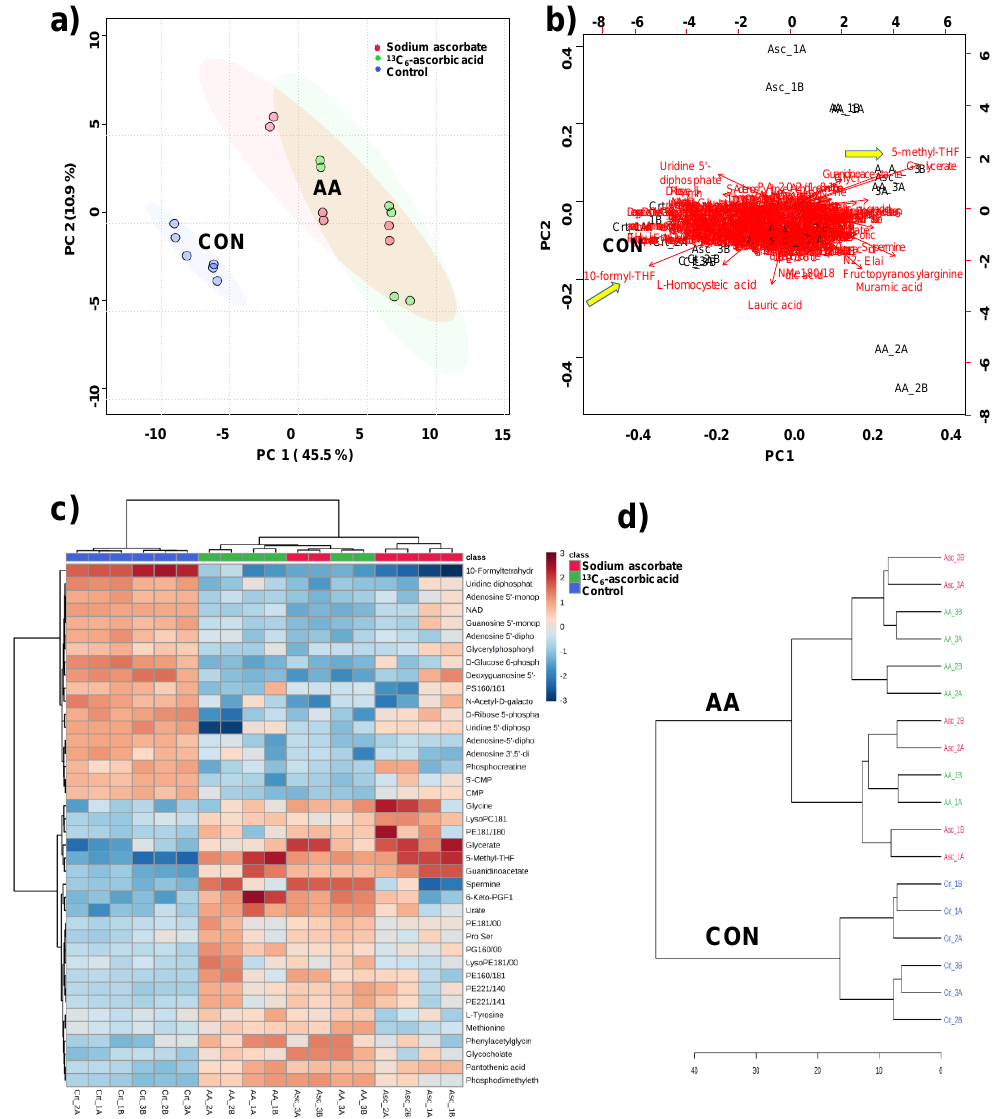
Figure 1. Analysis of treated C2C12 cells with ascorbic acid and with ascorbate 100 µM. ( a ) Principal component analysis (PCA) scores plot, where each dot represents a sample analysis (thus, 6 dots per experiment resulting from biological triplicates and technical duplicates); ( b ) PCA biplot visualizes which metabolites contribute most to the separation of the experimental groups; ( c ) heatmap visualizing the top 40 most differentiating metabolites. Color coding indicates greater deviation from the mean of all samples for a particular metabolite; ( d ) dendrogram indicating the degree of similarity among samples, constructed on the basis of all 204 metabolites. The analysis was performed using MetaboAnalyst V4.0.